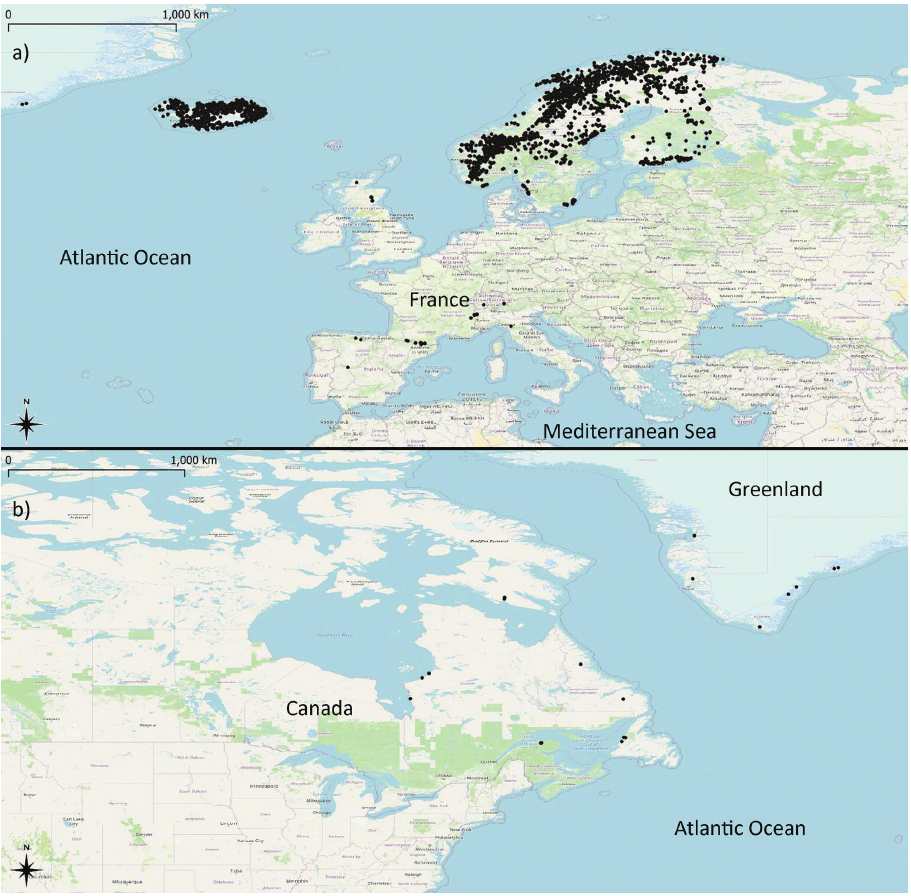
Figure 6. Global geographic range and distribution map of Viscaria alpina : a) Europe and b) North America and